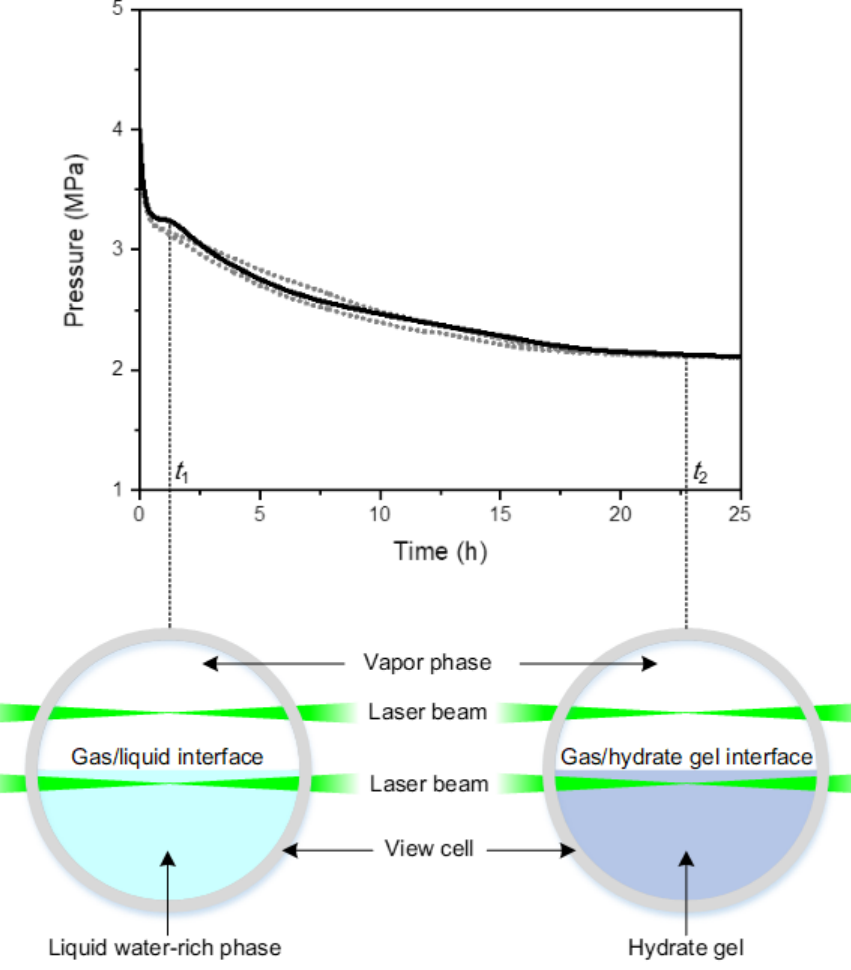
Figure 2. The temporal evolution of the pressure inside the view cell before and during the hydrate formation. The solid black line pressure profile represents an independent experiment, in which t 1 denotes the onset of the hydrate formation and t 2 the end of the hydrate formation period. The two grey dashed pressure curves represent two repetitions of the same experiment. Sketches are provided for two instants inside the view cell. The green lines indicate the path of the laser beam for composition measurements in the gaseous, liquid, and gel phases. Temperature T = 276.1 K.